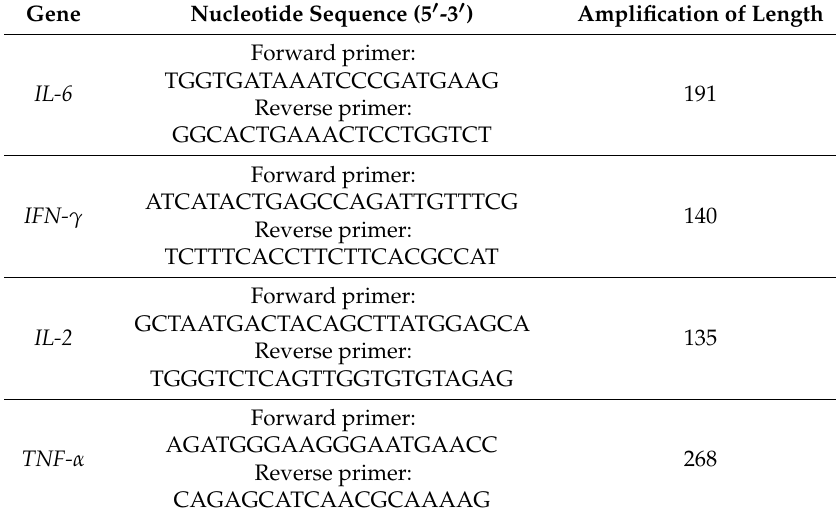
Table 8. List of specific primers sequence were used for IL-6 , IFN- γ , IL-2 , and TNF- α cytokine gene